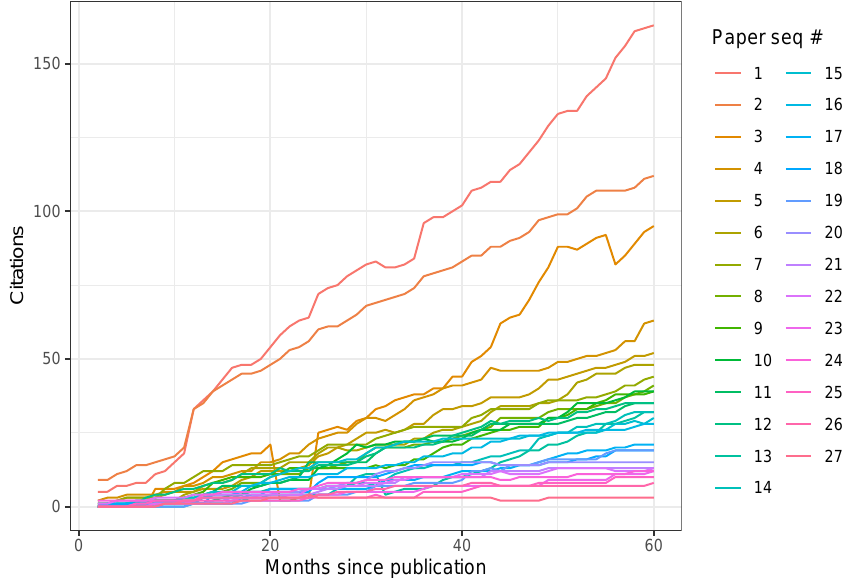
Figure 2. Total citations over five years, sampled monthly.